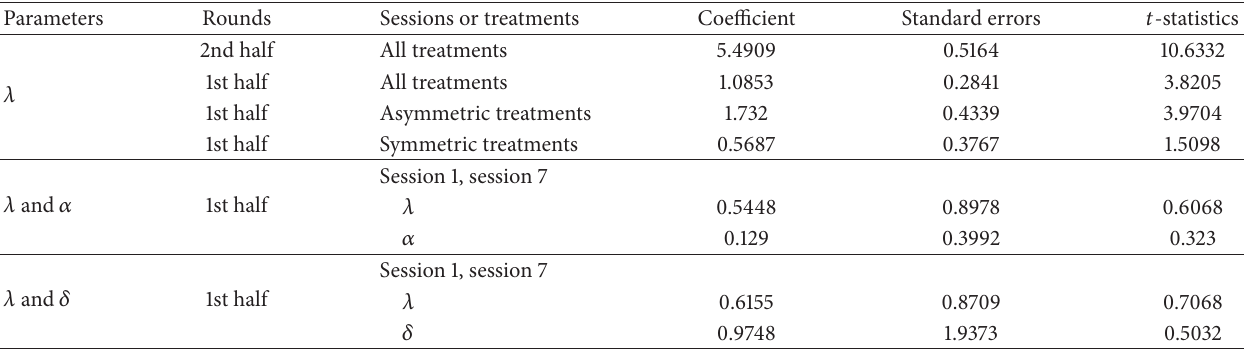
Table 8: Maximum likelihood